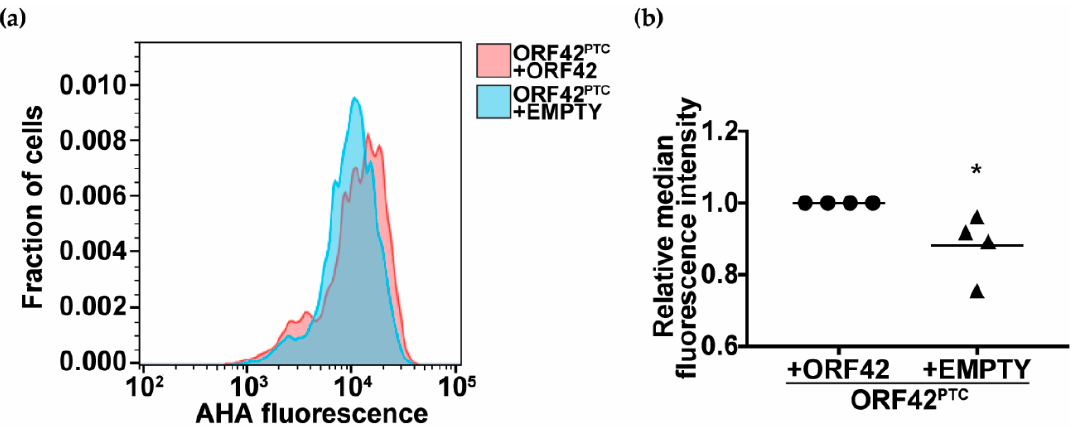
Figure 6. ORF42 affects total protein synthesis. Protein synthesis rates were measured using AHA-based metabolic labeling. The lytic cycle was induced in the indicated KSHV-infected iSLK.RTA cells by addition of doxycycline (1 μ g/mL) to the media. Five days after lytic cycle induction, nascent proteins were labeled using AHA coupled to a fluorescent dye. The fluorescence intensity of AHA-treated cells was measured by flow cytometry. The distribution of fluorescence in the cells is plotted in ( a ) for a representative replicate. In ( b ) the median fluorescence intensity of the cell population is plotted relative to KSHV ORF42 PTC -infected cells rescued with untagged ORF42. n = 4. * = p < 0.05 (Student’s t -test).